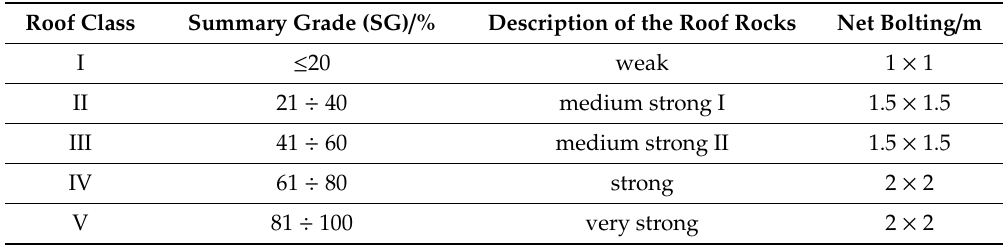
Table 2. Classification of roofs in copper ore mines due to the selection of rock bolt support.